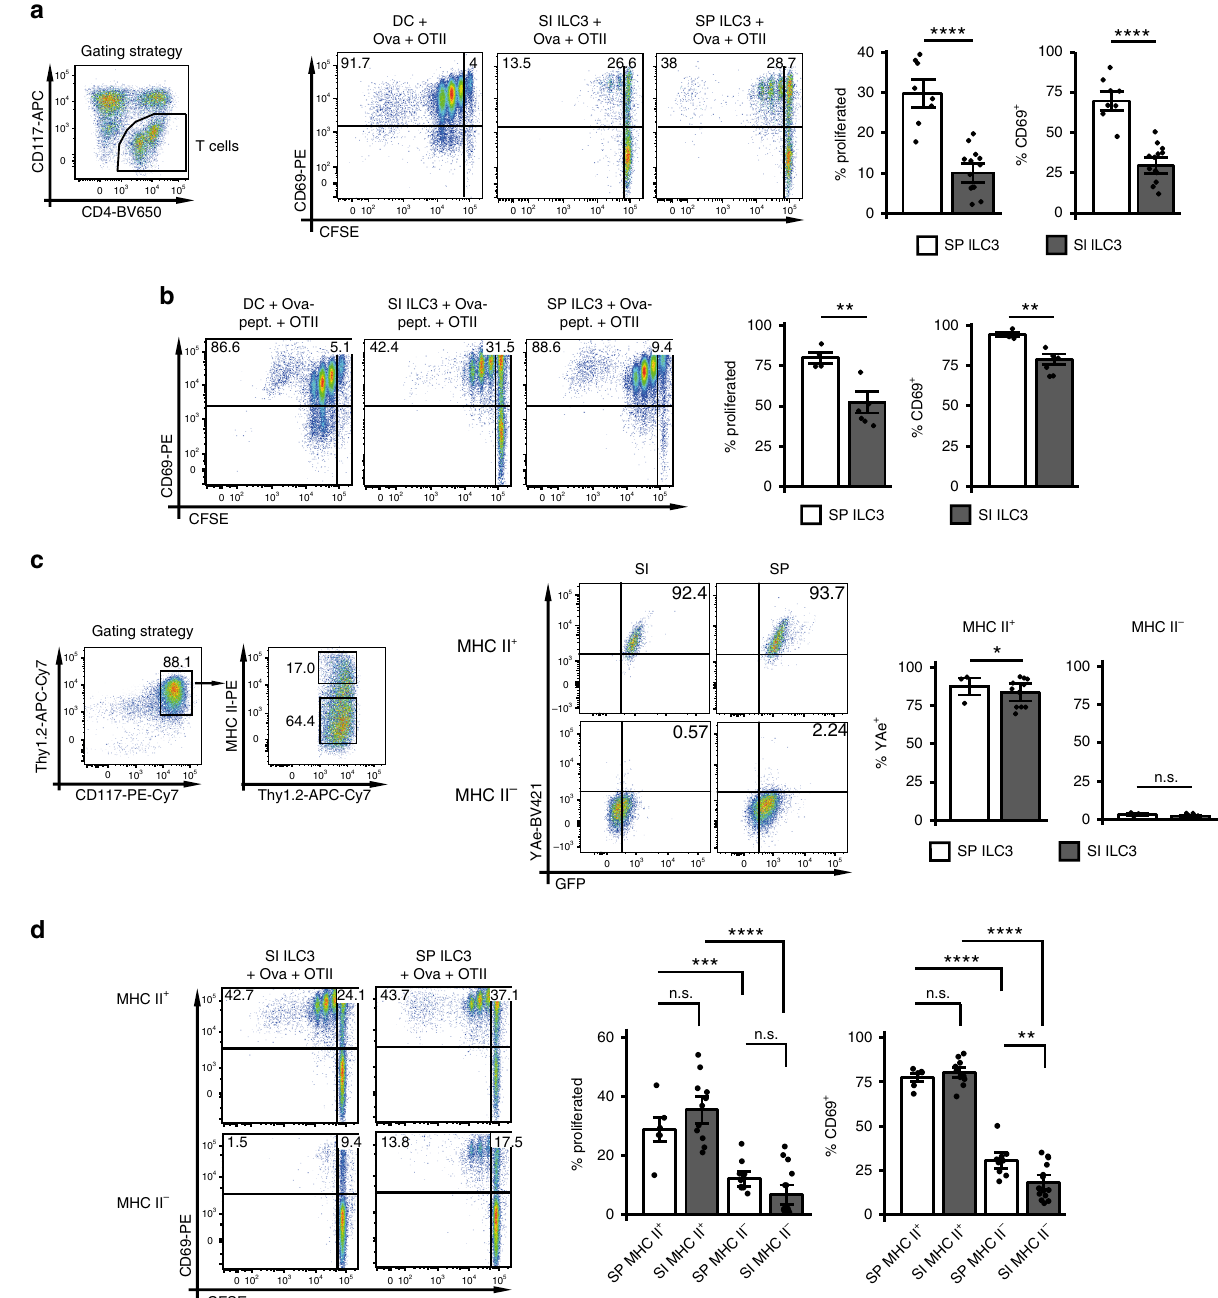
Fig. 2 SP and SI NCR − ILC3s differ in their capacity to stimulate CD4 + T cells. Naive CFSE-labeled OT-II tg CD4 + T cells were cultured either with 5 × 10 4 BMDCs, SP or SI ILC3s ( Rag2 − / − ) pre-activated with IL-1 β , in the presence of Ova protein ( a ) or peptide ( b ) for 72 h. ILC3s were sorted as depicted in Supplementary Fig. 2a. T cells were gated as CD3 + or CD117 − . In ( a ), n = 8 (SP) and n = 13 (SI) distinct samples. Six independent experiments. In ( b ), n = 4 (SP) and n = 6 (SI) distinct samples. Three independent experiments. c SP or SI ILC3s ( Rag2 − / − ) were cultured with E α -GFP protein for 72 h. ILC3s were sorted as depicted in Supplementary Fig. 2a. Surface presentation of E α peptide was analyzed by fl ow cytometry with antibody clone YAe. ILC3s were gated either on MHC II + or MHC II − CD117 + Thy1.2 + cells (gating strategy is depicted for SI ILC3s). n = 3 (SP) and n = 11 (SI) distinct samples of three independent experiments. d MHC II + ( n = 6 (SP) and n = 11 (SI) distinct samples) and MHC II − ( n = 10 (SP) and n = 15 (SI) distinct samples) ILC3s from SP and SI ( Rag2 − / − ) were stimulated with IL-1 β and used for T-cell stimulation in the presence of Ova protein. Five independent experiments. ILC3s were sorted as depicted in Supplementary Fig. 2a, e. T cells were gated as CD3 + or CD117 − . Each symbol represents a sample and the bar graph represents the mean ± s.e.m. n.s., not signi fi cant; * P ≤ 0.05; ** P ≤ 0.01; *** P ≤ 0.001; **** P ≤ 0.0001, calculated with mixed-effects models (two-sided) using lmerTest. Source data are provided as a Source Data